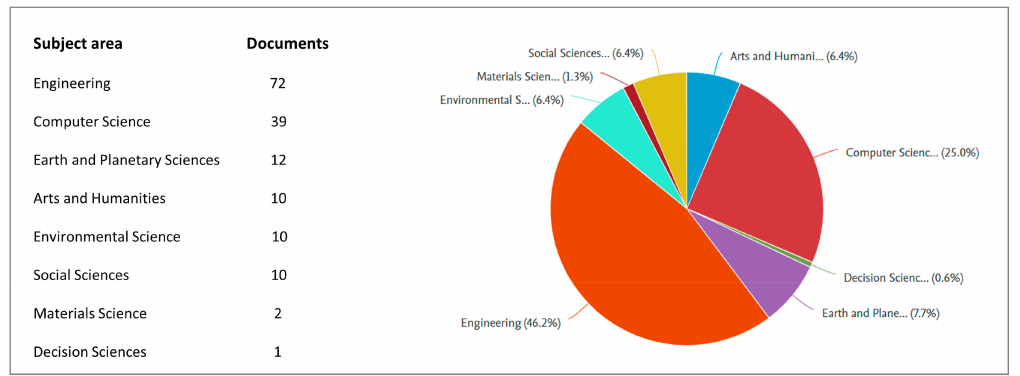
Figure 2. Distribution of subject areas of the selected 93